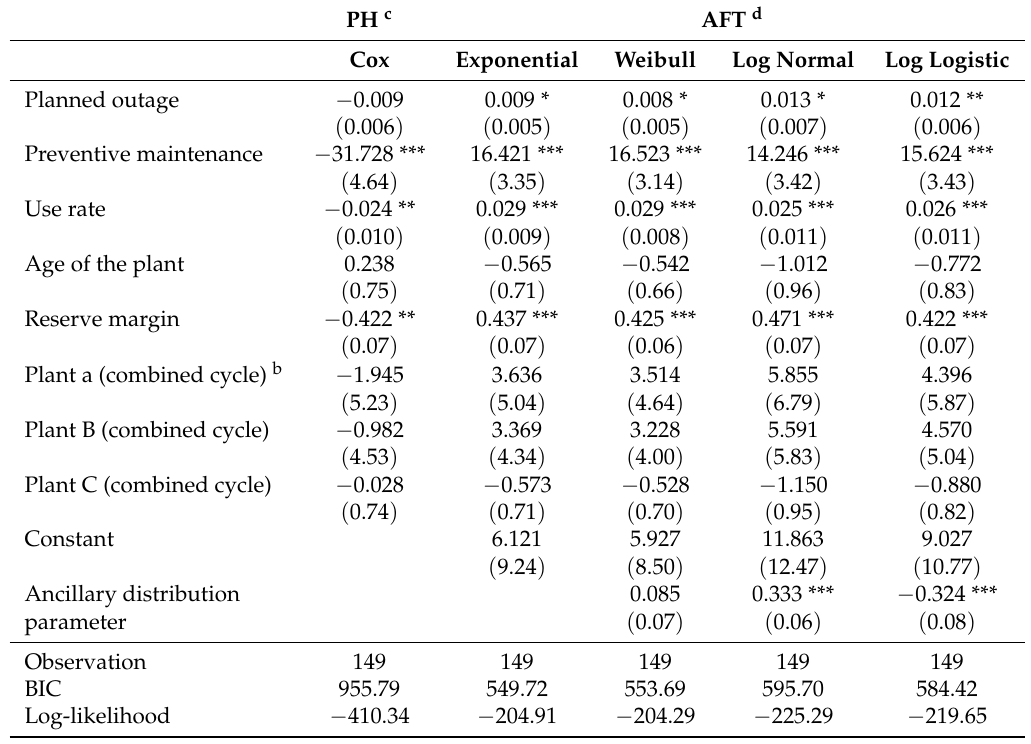
Table 2. Hazard model estimation results a